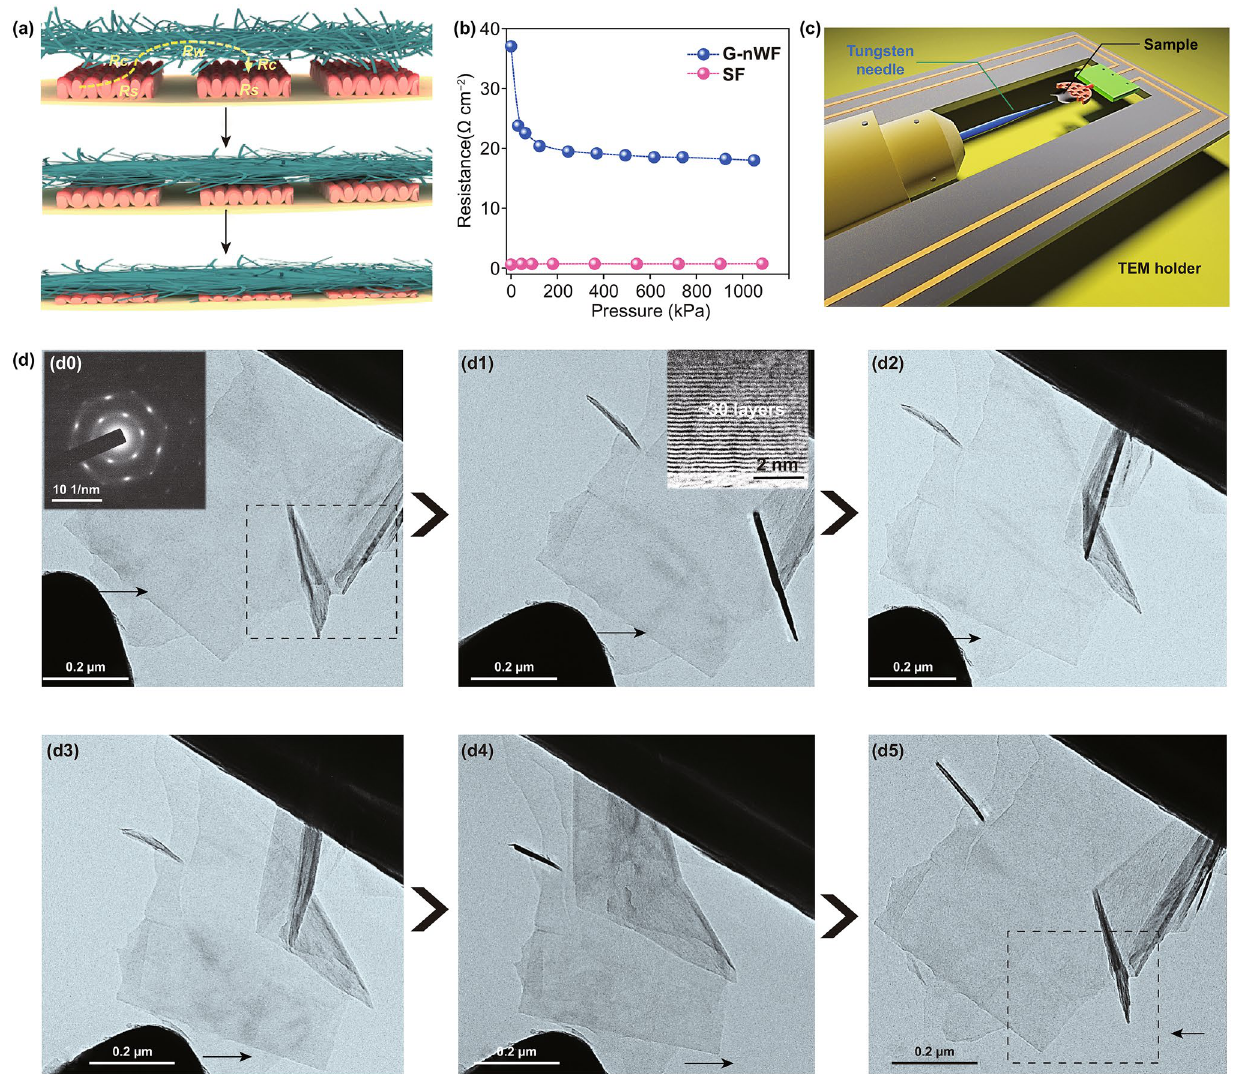
Fig. 4 Schematic illustration of the working mechanism of the sensor. a The proposed operating mechanism of the sensor. b Resistance changes of the G‑nWF and SF. c In situ TEM micro‑mechanical device for the GFs. d In situ micro‑mechanical characterization of GFs inside TEM, demonstrating its superior mechanical